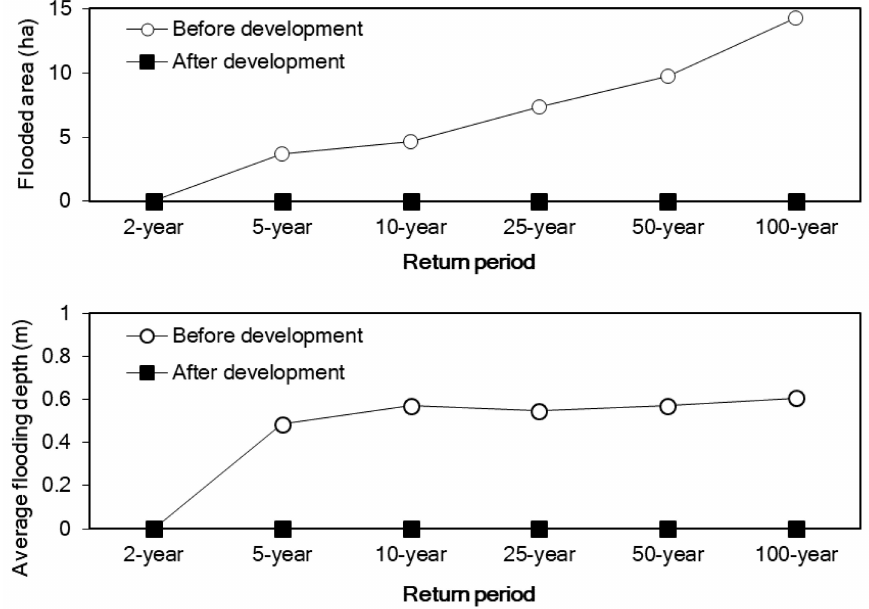
Figure 8. Comparison of flooding range and average flooding depth of various return periods before and after land development in development zone.